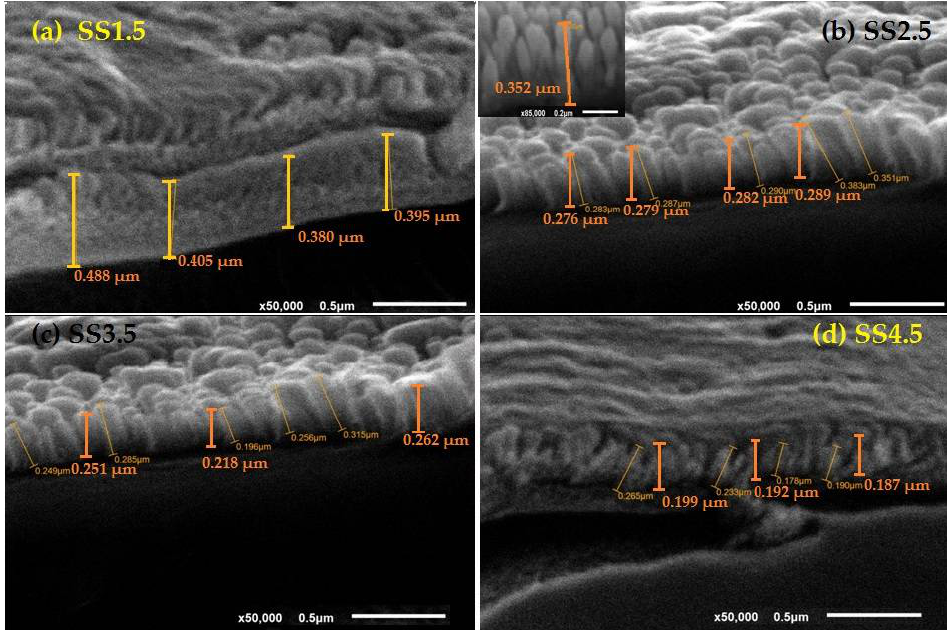
Figure 1. ( a–d ): FE-SEM image of IrOx films spin deposited at spin speed (SS) of ( a ) (1.5–4.5) × 10 3 rpm. The inset of ( b ) shows the nanorod morphology (scale bar 0.2 µm and magnification ×50,000). Table 1. Values of the average thickness ( d av . ) and direct bandgap ( E g ) of the IrO x